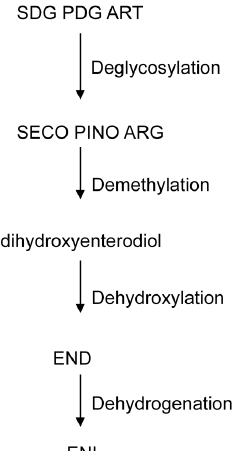
Figure 3. Metabolism of the lignans by intestinal microbiota. Pinoresinol diglucoside (PDG), arctiin (ART) secoisolariciresinol diglucoside (SDG), secoisolariciresinol (SECO), pinoresinol (PINO), arctigenin (ARG), enterodiol (END) and enterolactone (ENL).